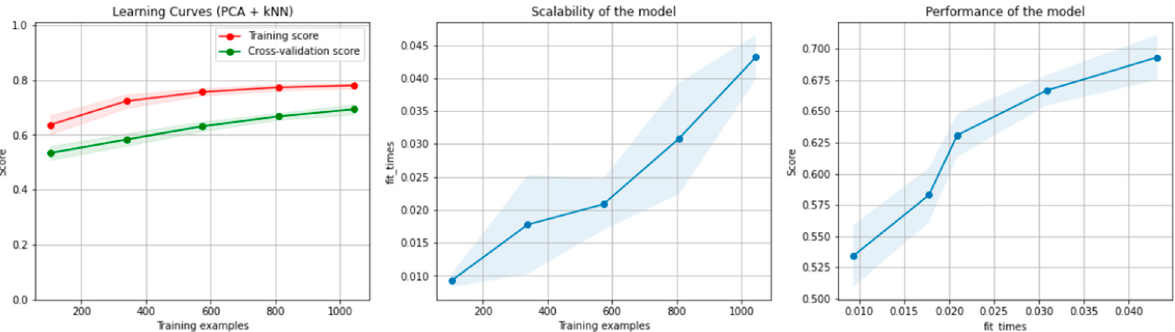
Figure 11. Learning curves, scalability and model performance for the PCA + kNN algorithm, for the non-overlapping dataset.